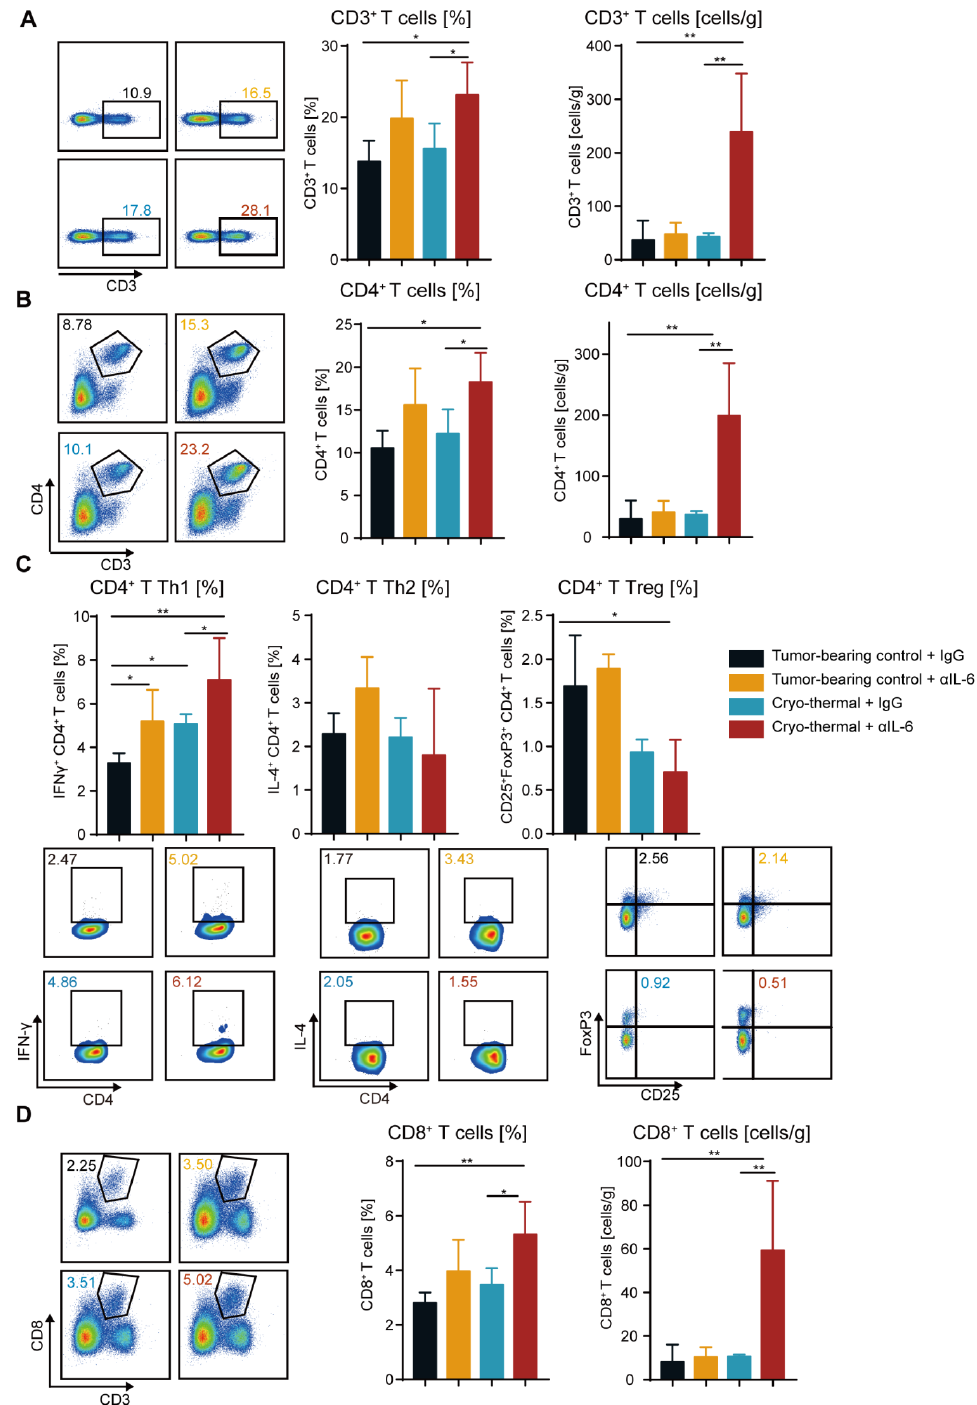
Figure 4. Combination therapy promoted the increase and antitumor activities of T cells. ( A , B ) The proportion and absolute number of CD3 + T cells ( A ), CD4 + T cells ( B ) in the spleen were analyzed by flow cytometry. ( C ) The subsets of CD4 + T cells in the spleen. ( D ) The percentage and absolute number of CD8 + T cells in the spleen. In the representative graph of flow cytometry, black represent tumor-beaing control + IgG, orange represent tumor-beaing control + α IL-6, blue represent cryo- thermal + IgG, red represent cryo-thermal + α IL-6. n = 4 for each group * p < 0.05, ** p < 0.01. Data were analyzed using one-way